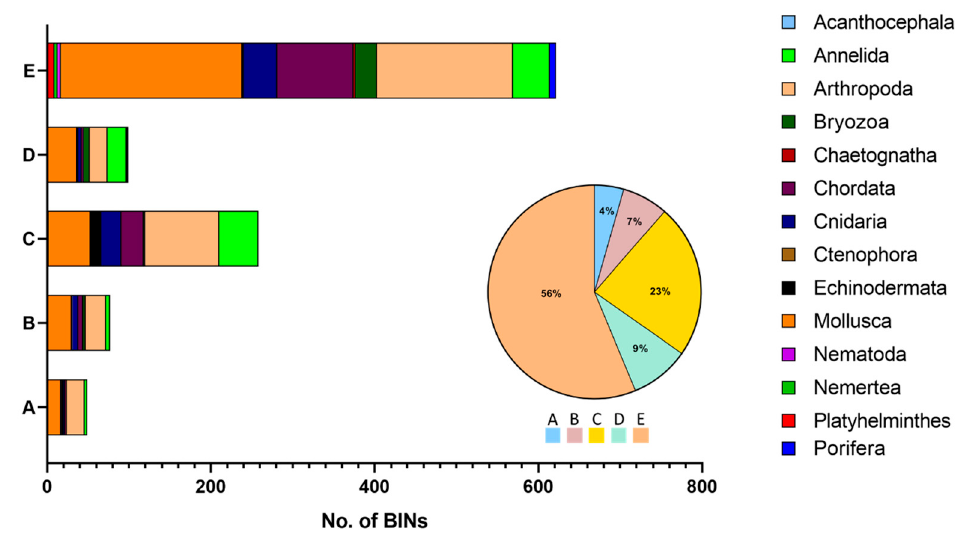
Figure 3. Taxonomic composition of the graded BINs resulting from the BAGS analysis. A and B represent concordant records, C records with multiple BINs for the same species, D records with insufficient data, and E discordant records (more than one species in the same BIN). Chordata only includes Ascidiacea.